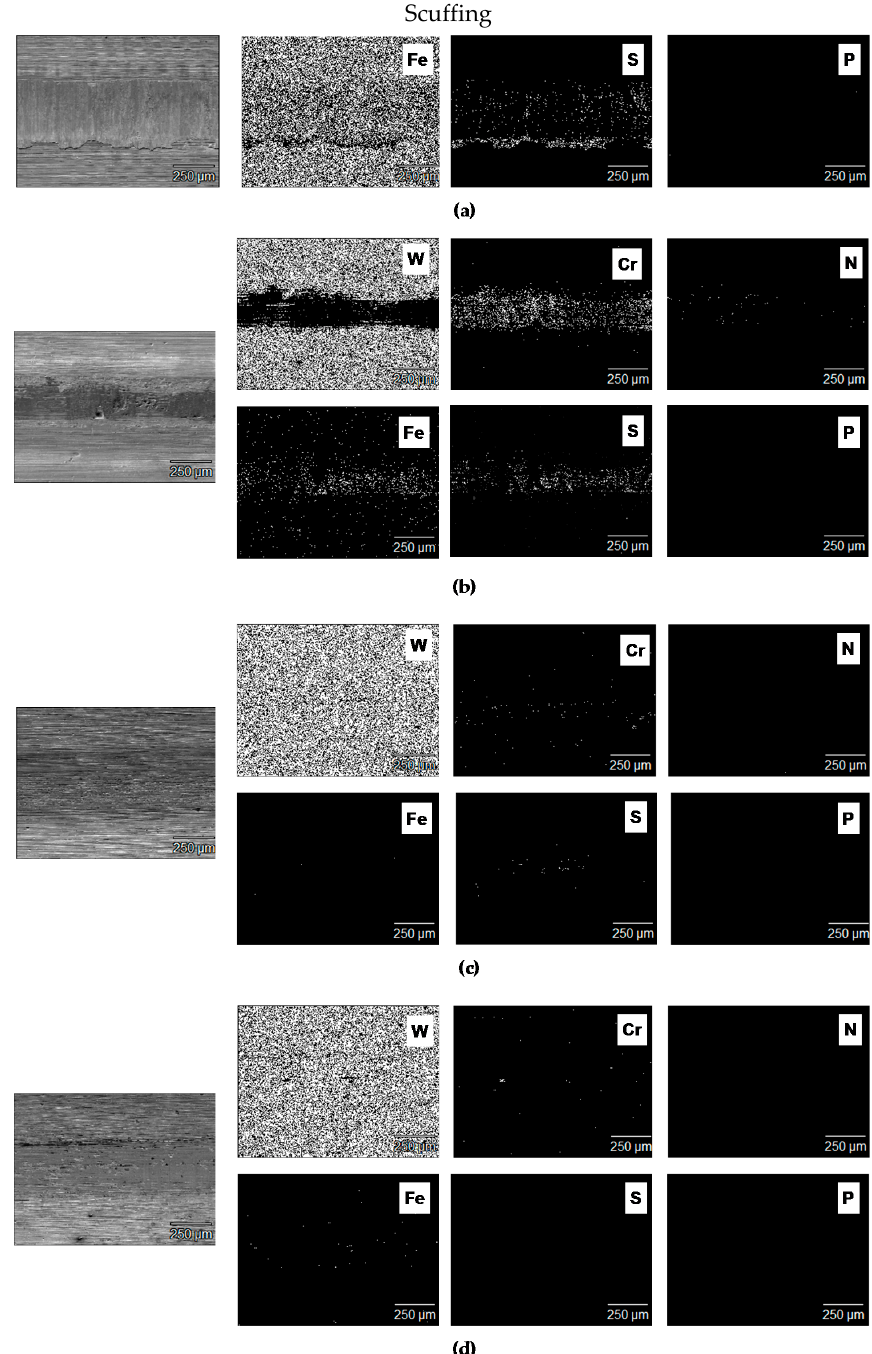
Figure 14. SEM images (on the left) and EDS surface analyses of the wear scars on the vee blocks: ( a ) Uncoated vee block lubricated with the mineral oil; ( b ) (W ‐ DLC/CrN) ‐ coated vee block lubricated with the mineral oil; ( c ) (W ‐ DLC/CrN) ‐ coated vee block lubricated with the PAO oil; and ( d ) (W ‐ DLC/CrN) ‐ coated vee block lubricated with the PAG oil.